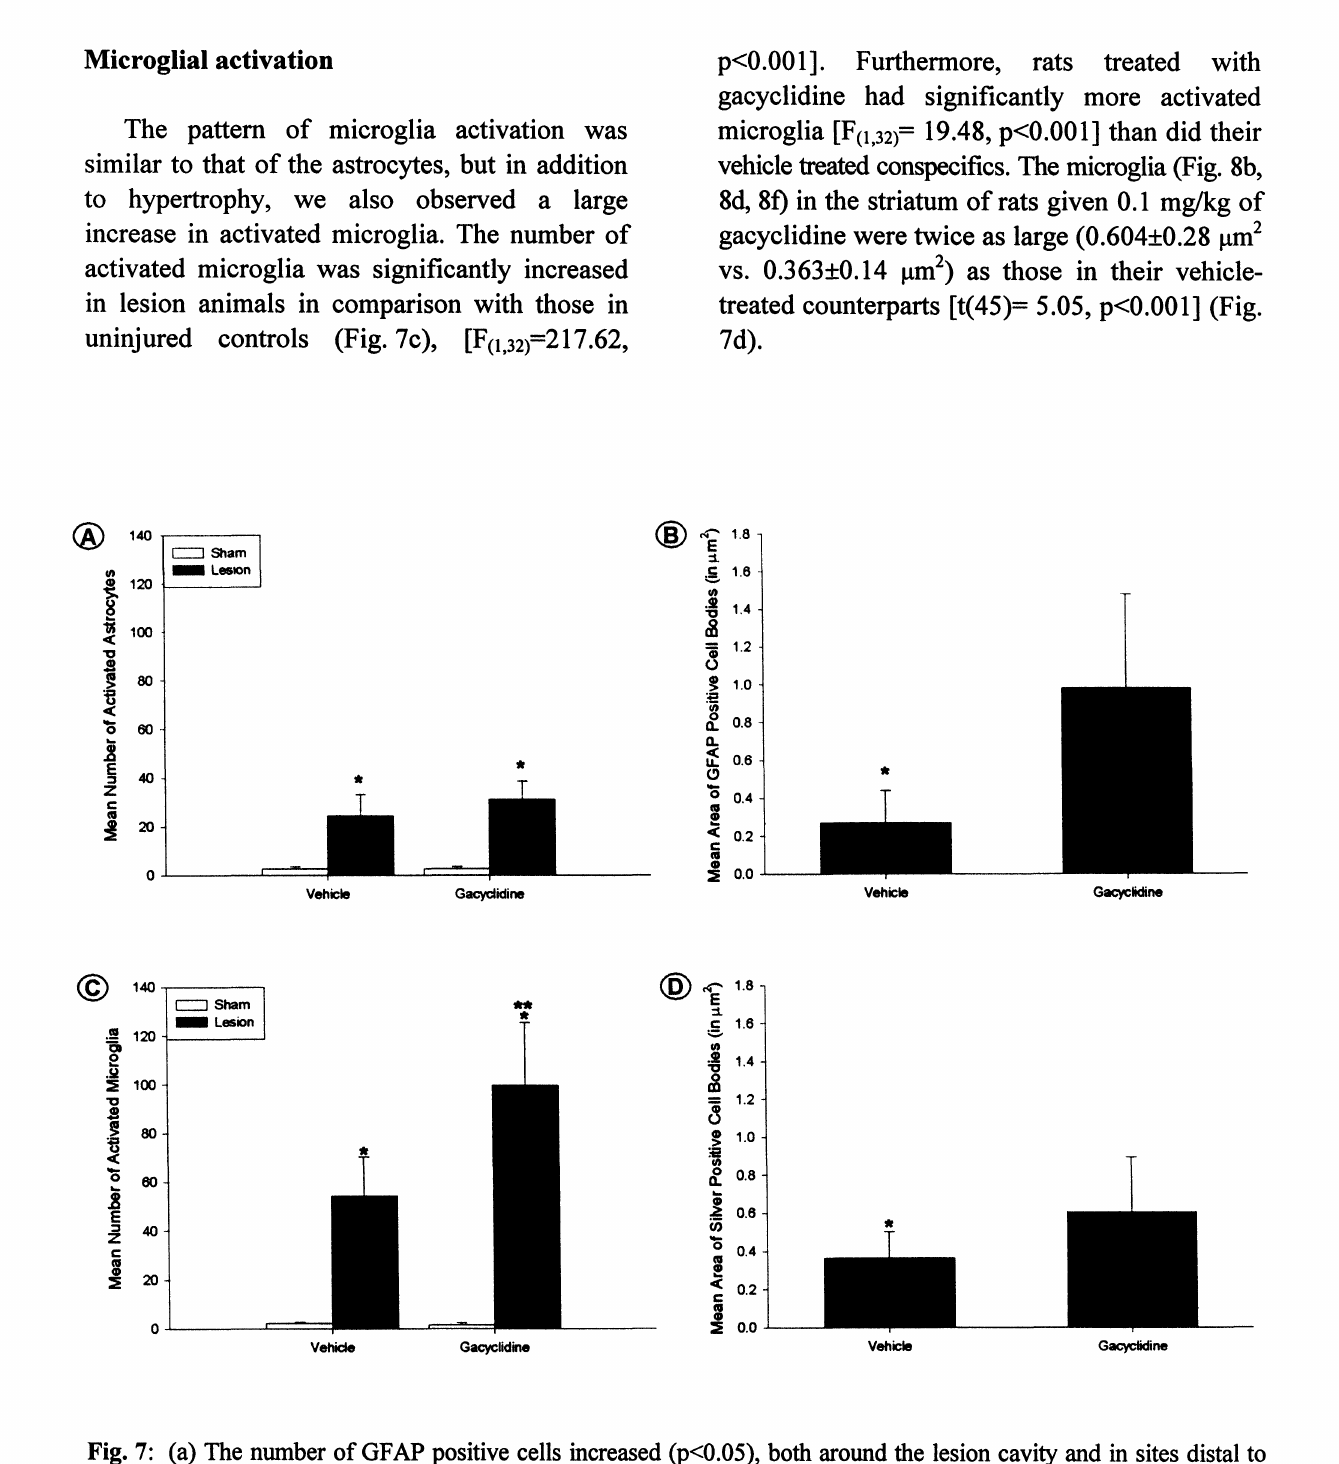
Fig. 7: (a) The number of GFAP positive cells increased (p<0.05), both around the lesion cavity and in sites distal to the locus of injury. In the striatum, rats given 0.1 mg/kg of gacyclidine showed no increase in the number of activated cells (p=0.08), but (b) did show increases in size (*=p<0.05). At 26 d post injury in rats receiving 0.1 mg/kg gacyclidine, (c) the numbers of activated microglial cells at sites distal to the cavity formation were increased (*,**=p<0.05), and (d) the size of microglial cells in the striatum was increased